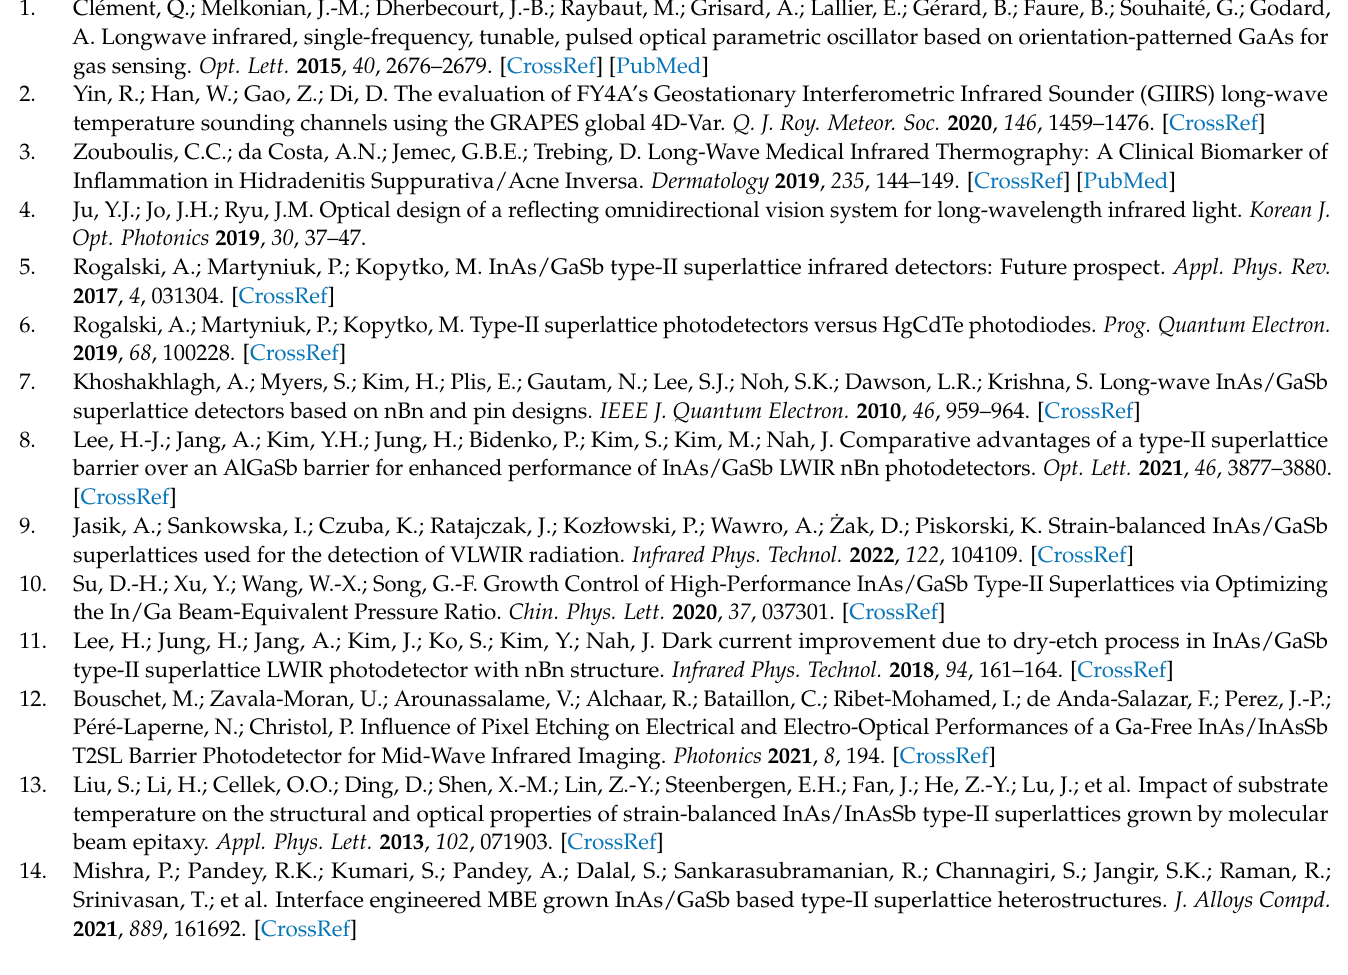
Figure S2: The binding rate of Ga and Sb to oxygen under different atmospheric exposure times; Figure S3: Reflection high energy electron diffraction of reconstruction processes; Figure S4: Spiral dislocations on the surface of GaSb buffers grown on GaSb substrates with 224.71 Å oxide thickness were observed by atomic force